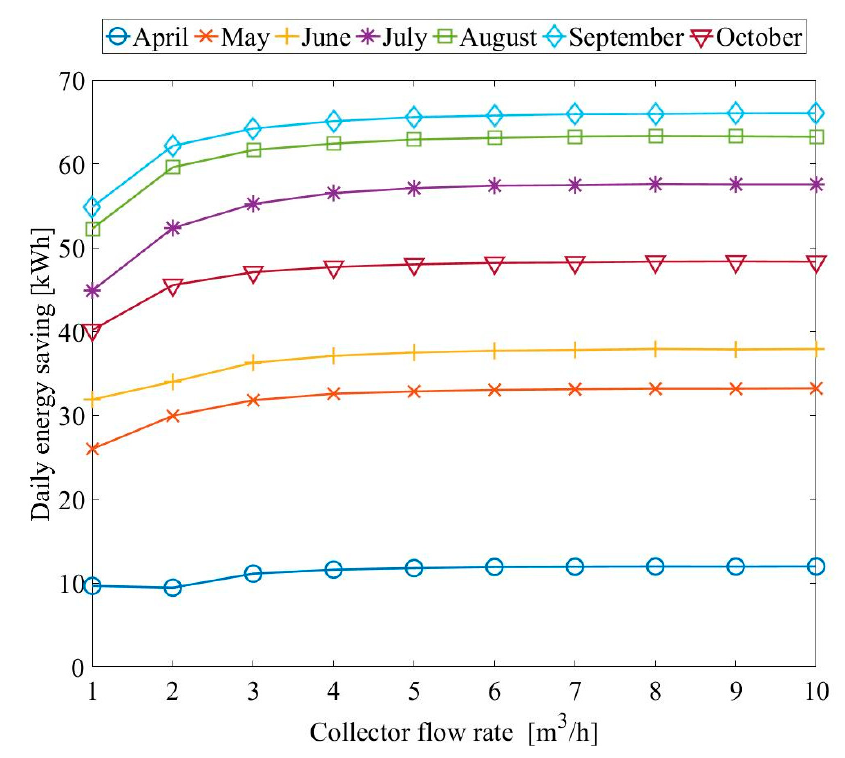
Figure 10. Daily energy saving for different collector flow rates based on the data from Apr to Oct.